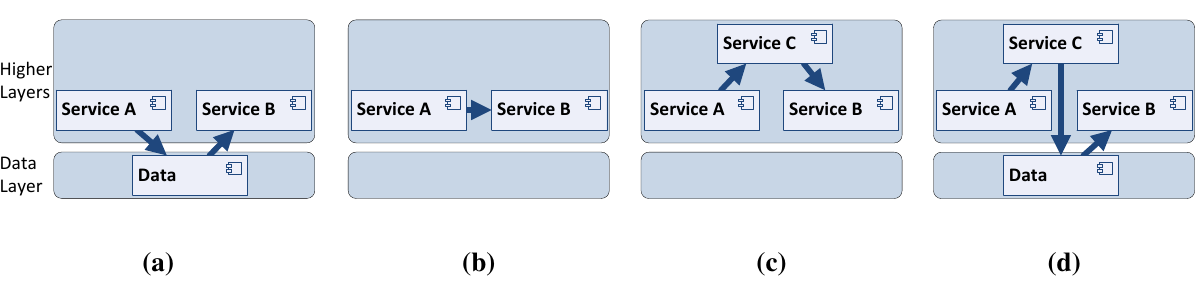
Patterns for passing data between adjacent services in a service chain. ( a ) Persistent; ( b ) direct; ( c ) mediated; ( d ) mediated